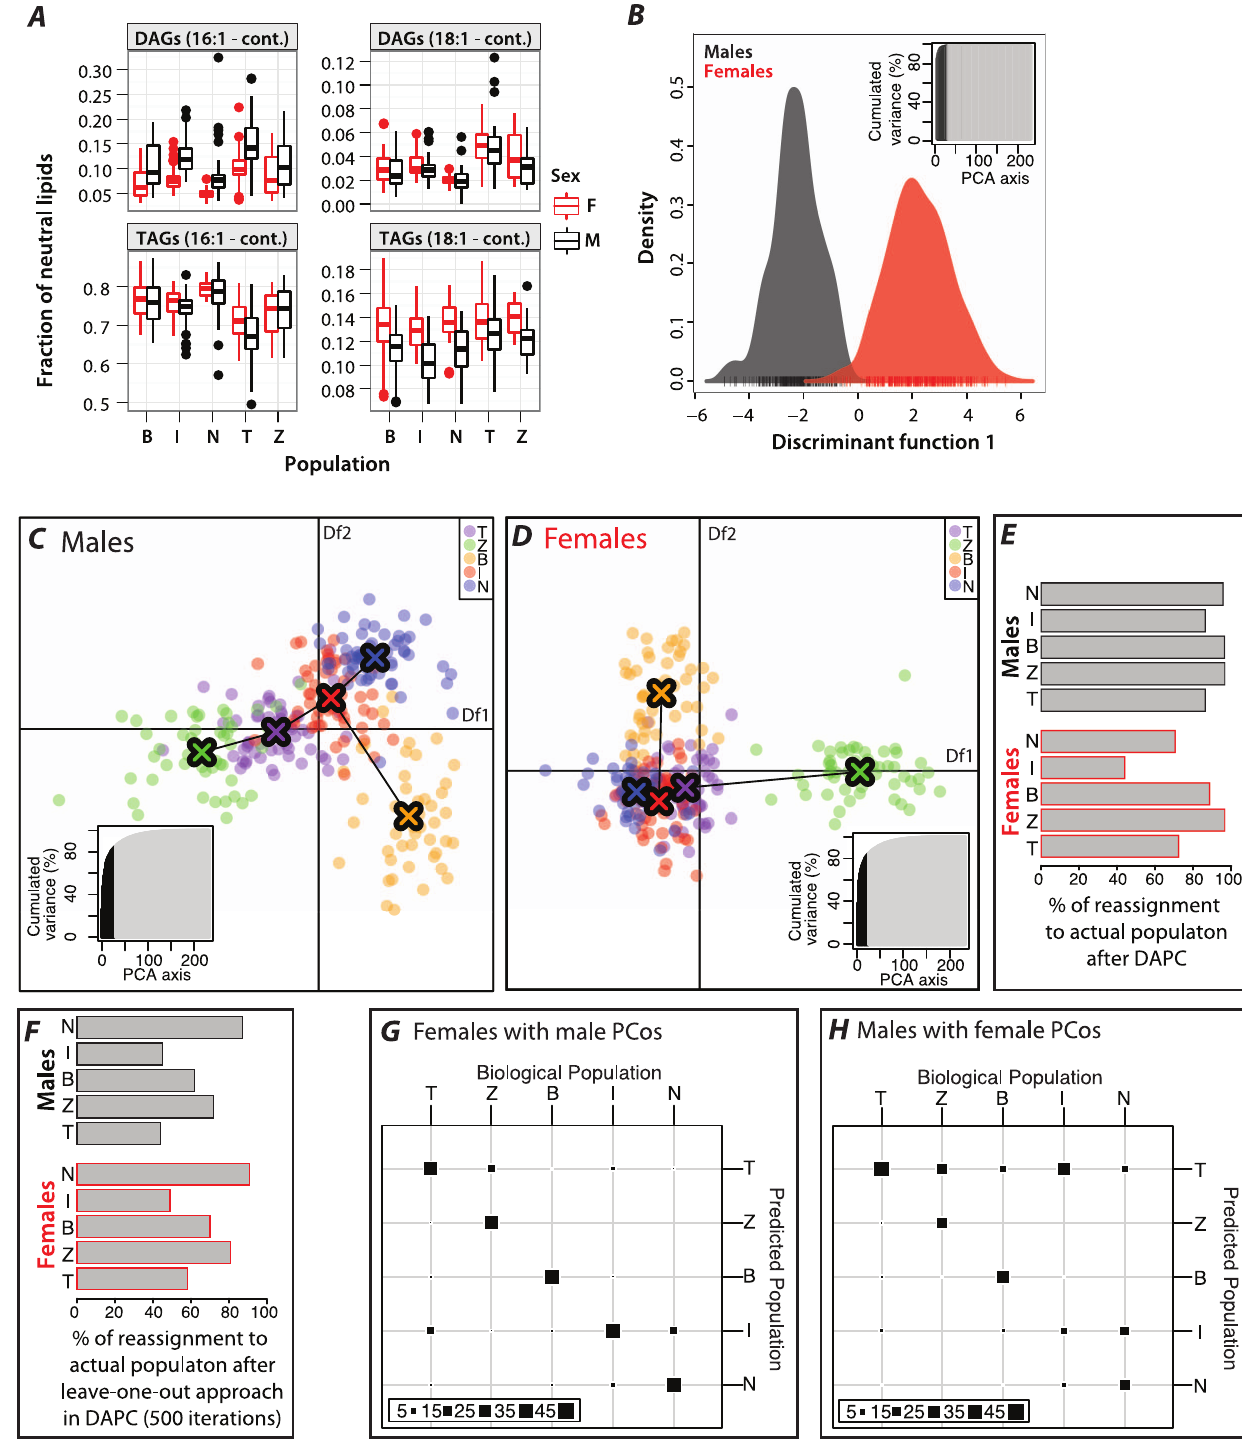
Figure 6. DAPC analysis reveals clear population separation in either males or females. A: Fraction of neutral lipids across population and sex. Value in brackets (cont.) identifies one FA of a total 2 for DAGs and a total 3 for TAGs. B: DAPC analysis for all flies investigating the sex separation. Inset shows the total variance explained by the PCos. Retained PCos are colored black. C and D: DAPC analysis for males (C) and females (D) separating the 5 populations. Colored crosses and their connections show the minimum-spanning tree based on the population distances. Df=Discriminant function. Inset as in B. E: Percent of individuals that are assigned to their biological population using the DAPC of C and D. F: Leave- one-out approach testing the robustness of the population assignment from the DAPC analysis in C and D. G: Eigenvectors from the male DAPC (C) are applied to the female lipid dataset, and it was determined how well this allows for population separation by measuring the re-assignment of individuals to their biological population. H: Same as F, but female derived eigenvectors are applied to the male dataset.